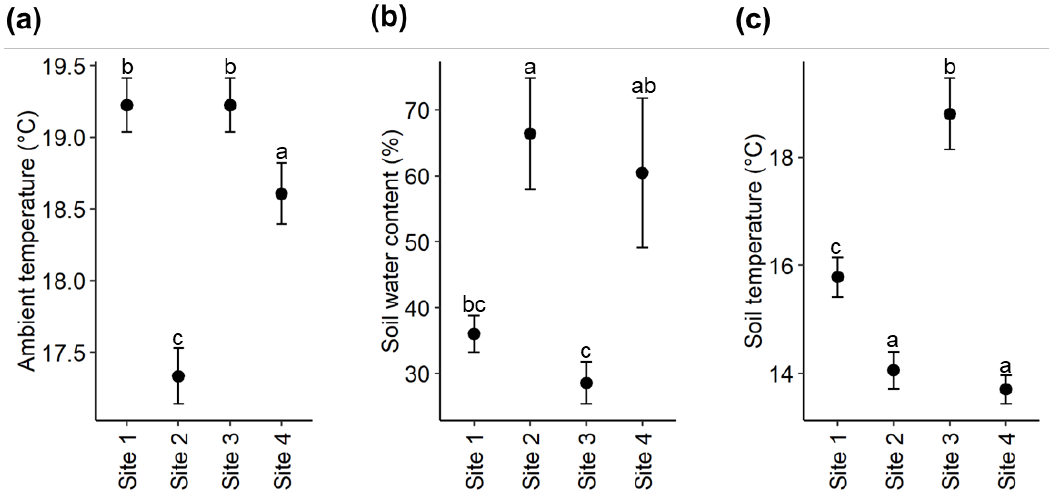
Figure 4. Comparison of ( a ) ambient daytime temperature, ( b ) soil water content and ( c ) soil temperature between sites. The y -axis showing mean ± SE values and x -axis representing the four study sites. Different letters indicate significant differences.